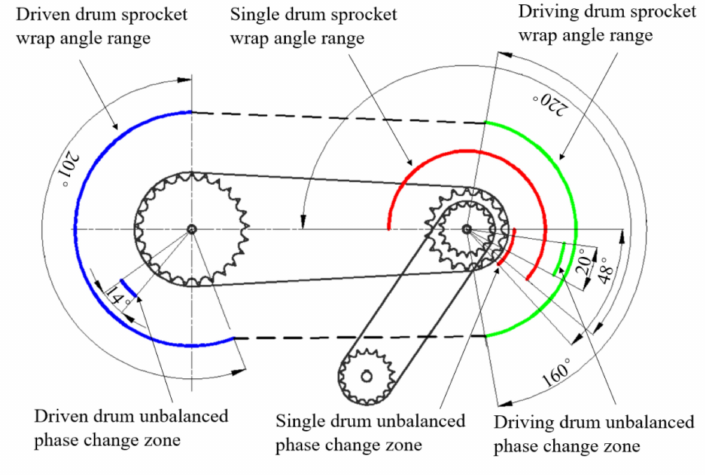
Figure 12. Schematic diagram of double threshing drums dynamic balance method.